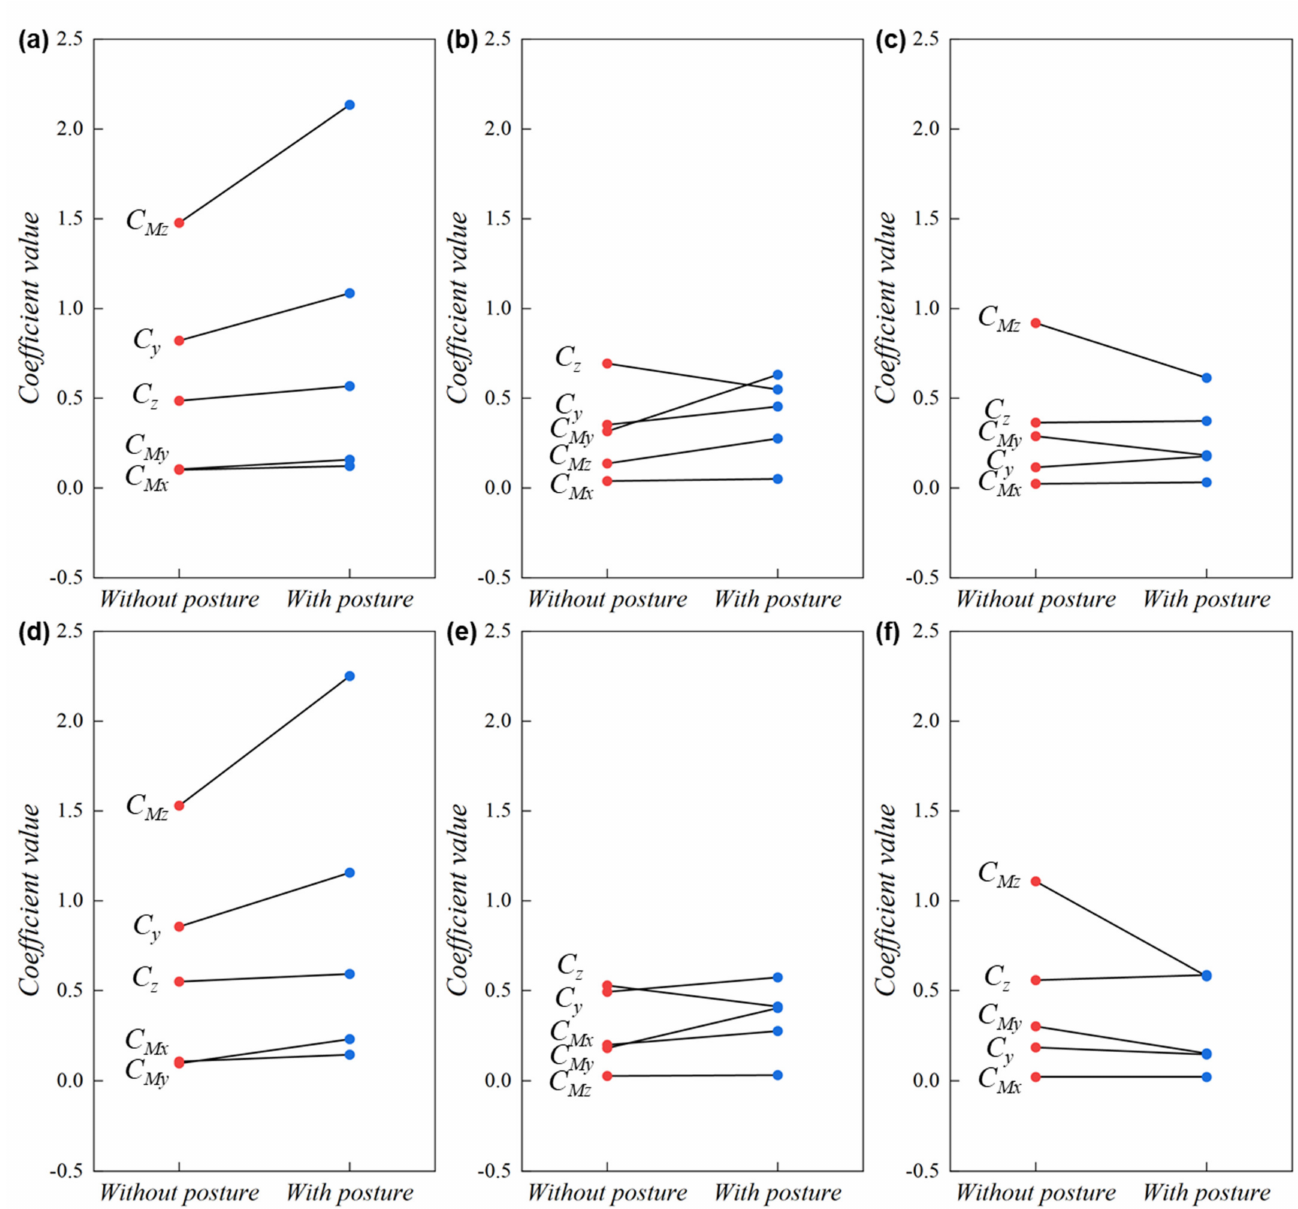
Figure 8. Peak-to-peak values of the aerodynamic coefficients when each car entered and left the crosswind region with and without posture.: ( a ) entry of leading car; ( b ) entry of middle car; ( c ) entry of trailing car; ( d ) exit of leading car; ( e ) exit of middle car; ( f ) exit of trailing